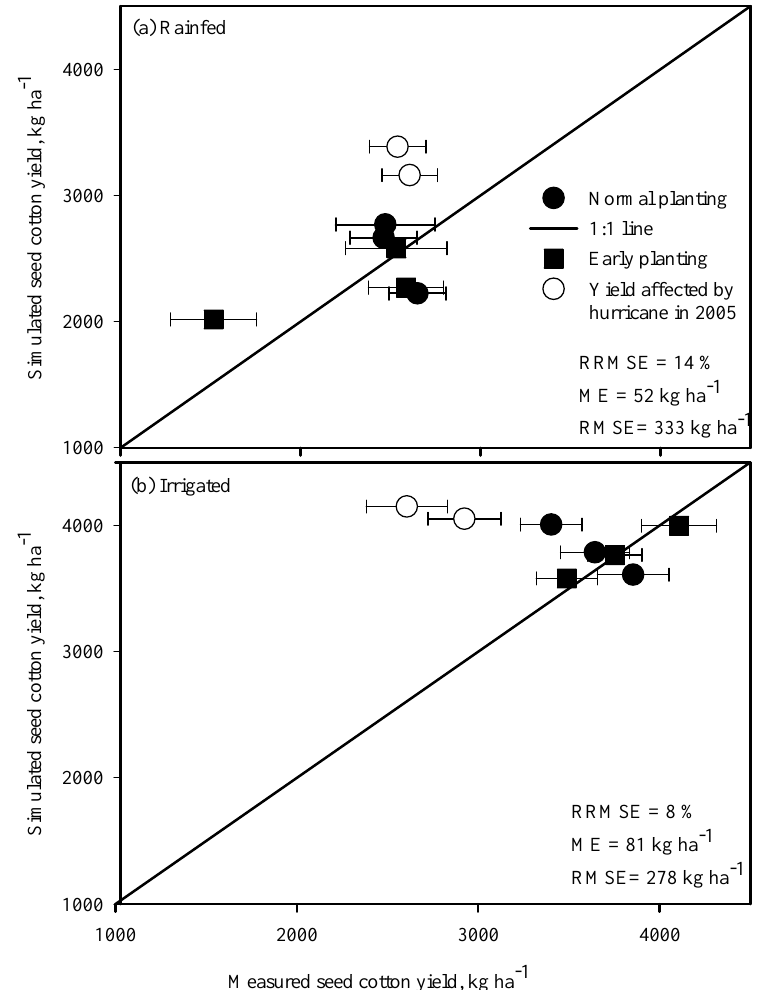
Figure 1. Measured and simulated seed cotton yield from normal and early plantings under rainfed ( a ) and irrigated ( b ) conditions during 2005–08 at Stoneville, MS. Error bars indicate one SD from the mean of the measured yield across the four treatment replications. RMSE = Root Mean Squared Errors. RRMSE = RMSE relative to mean values. ME = Arithmetic Mean Error.